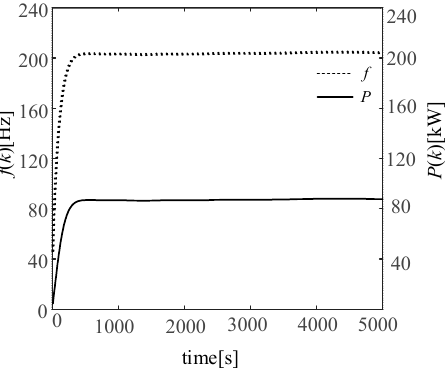
Figure 7. Response curve of system control variable f ( k ) and intermediate variable P ( k ).